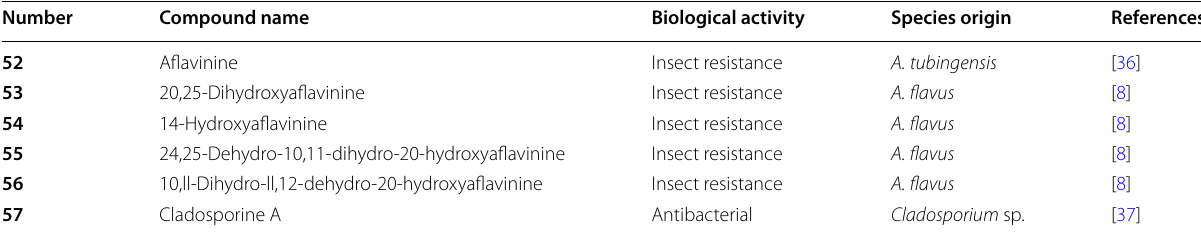
Table 4 Name, bioactivities and source of aflavinine